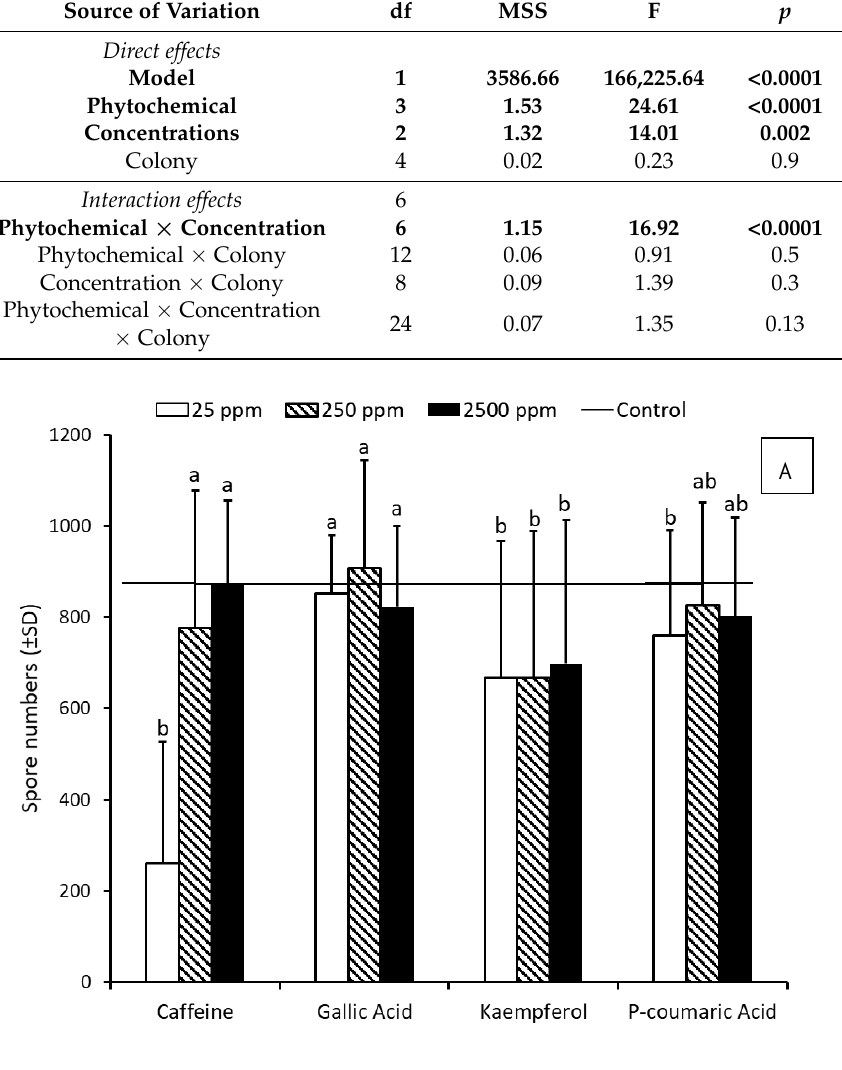
Figure 2. Spore loads (untransformed values) in dead infected bees ( A ) and median longevity of bees ( B ) that received dietary supplementation of phytochemicals at different concentrations (N = 30 bees for each phytochemical treatment; N = 22 for Control). Bars with different letters are significantly different from the control (Spore loads ( A ): GLM Univariate ANOVA followed by Tukey’s post-hoc comparison of log-transformed spore loads; Longevity ( B ): Median test).